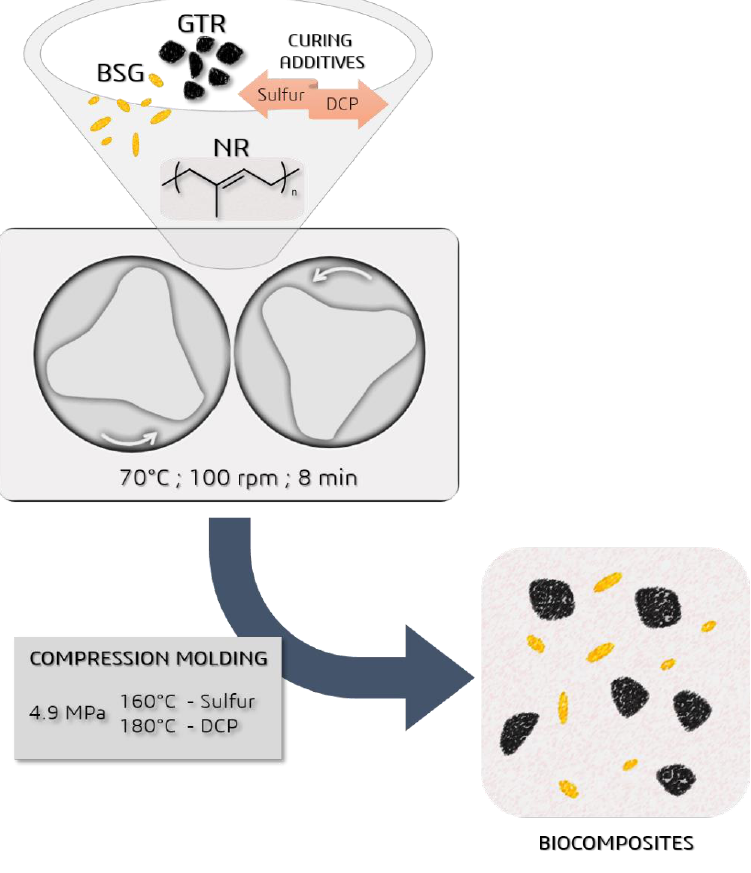
Figure 1. Sample preparation procedure .